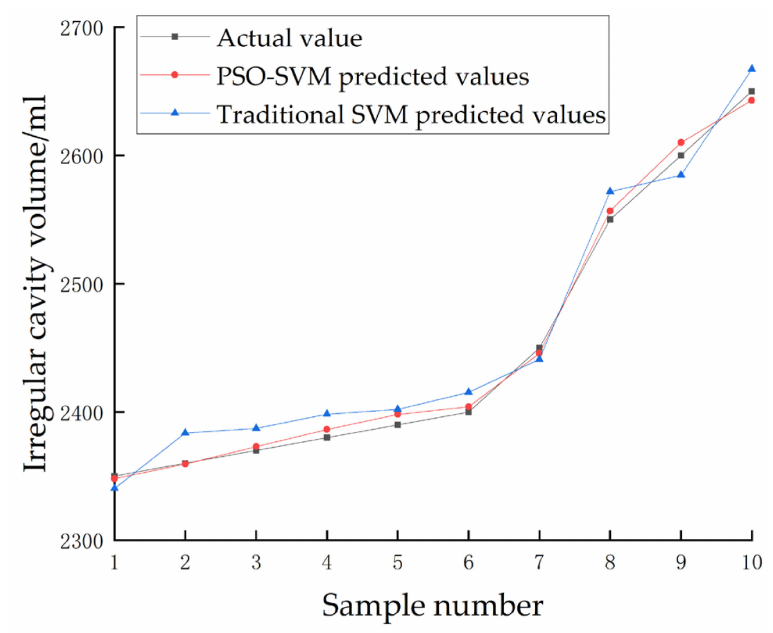
Figure 4. Simulation results from three